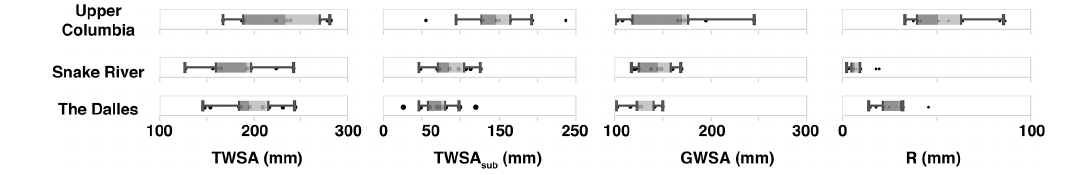
Figure 6. The intra-annual range of TWSA, TWSA sub GWSA, and R for the 9 water years of the study period.